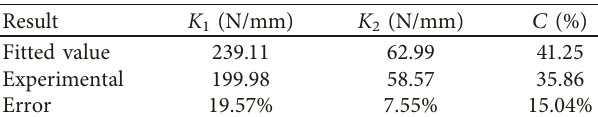
Figure 13: Experimental compression load-displacement results [24]. Table 11: Comparison between the fitted value and experimental